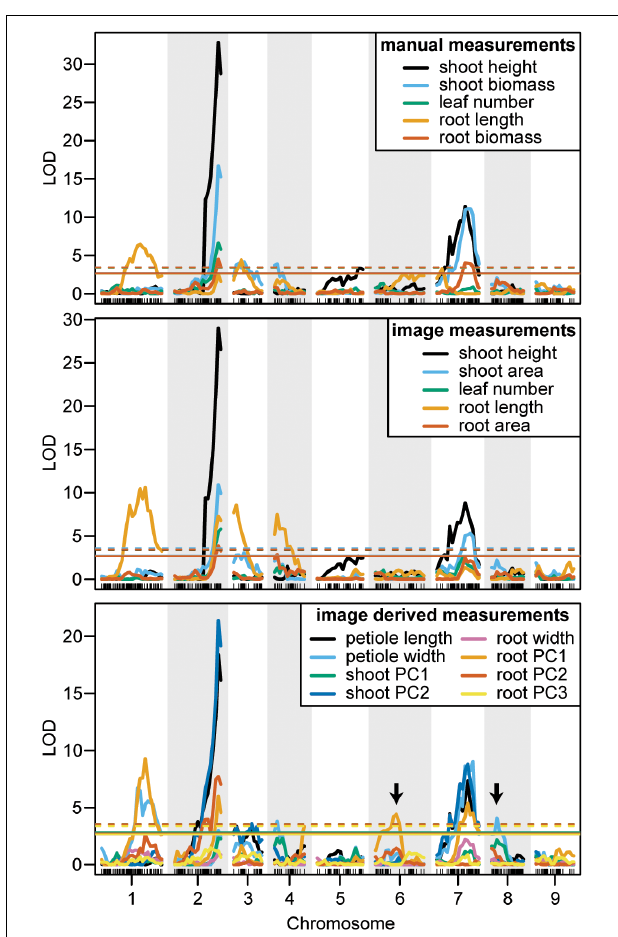
FIGURE 7 | LOD curves for manually measured traits (top), image measured traits which were analogous to manual measurements (middle), and traits that were only measured from images (bottom). Arrows designate QTL that were identified by image measurements but not by manual measurements. Horizontal lines indicate the significant LOD thresholds for P < 0.05 (solid) and P < 0.01